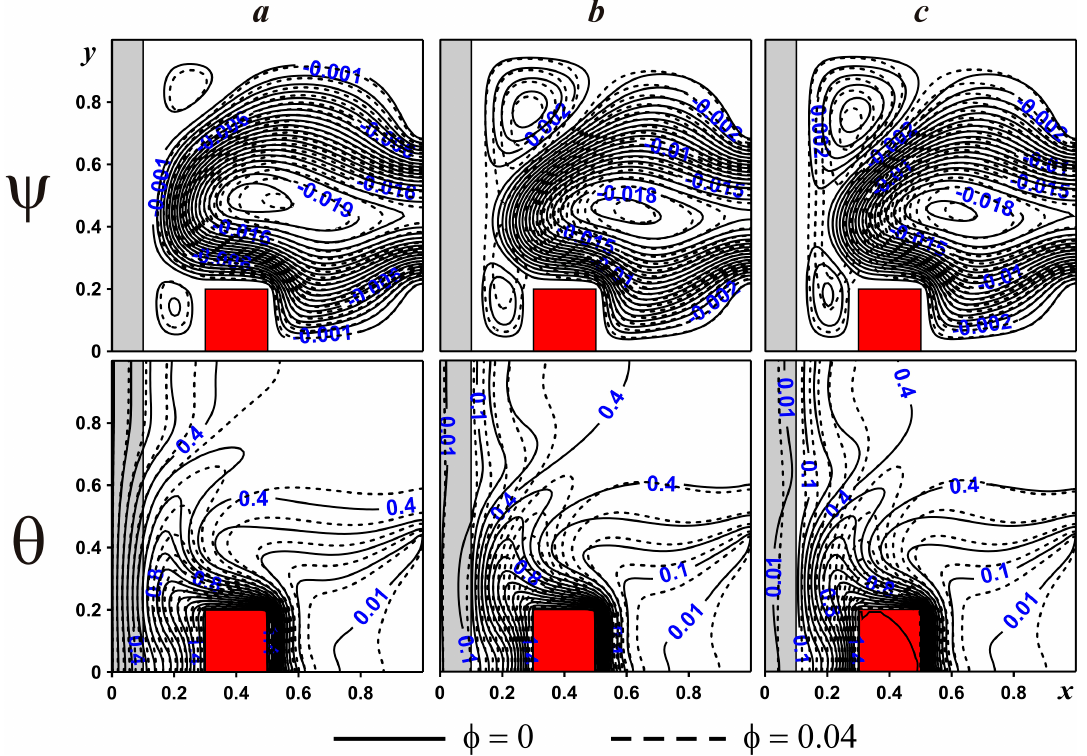
Figure 5. Streamlines ψ and isotherms θ for Ra = 10 5 , δ = 0.2: K r = 1 ( a ), K r = 5 ( b ), K r = 20 ( c ).